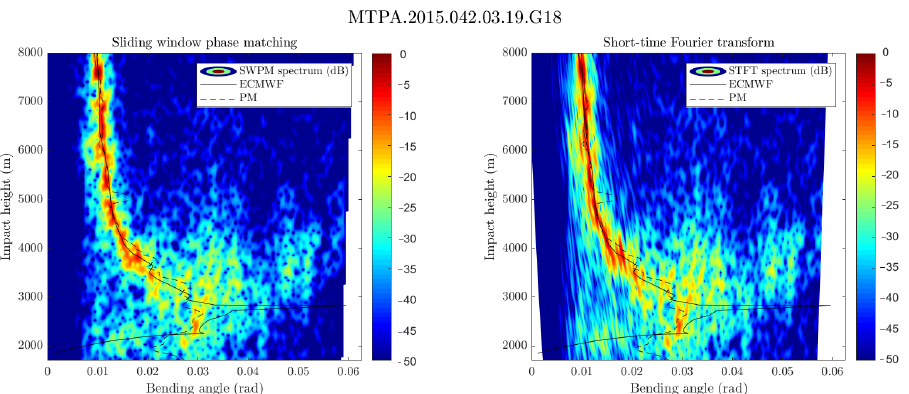
Figure 10. A MetOp-A occultation from UTC 0319 2015-02-10, 28.61 ◦ S, 71.14 ◦ E. Left shows SWPM, right shows STFT. ECMWF BA is shown in solid black, standard PM is shown in dashed black. The window length for STFT is 1.9 s.